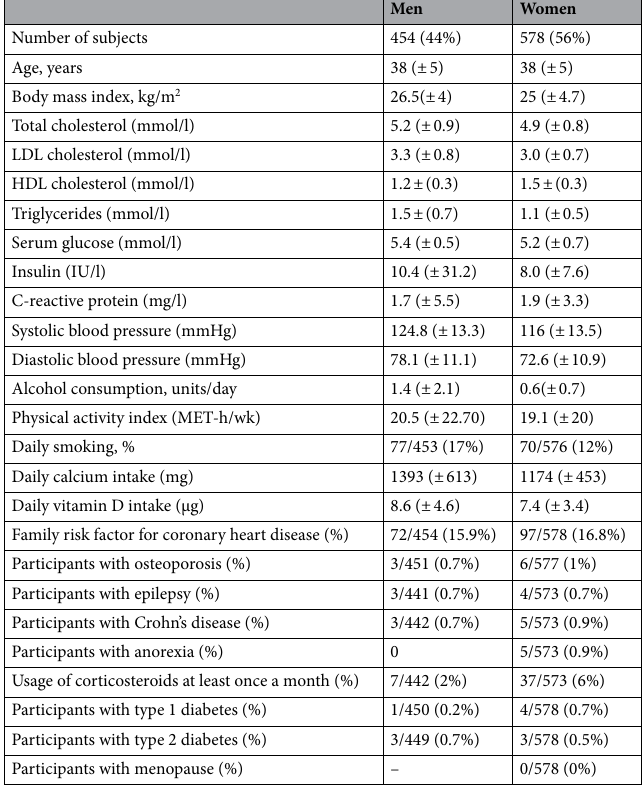
Table 1. Population characteristics of the Young Finns Study cohort. Data are expressed as means (± SD) or proportions (%).